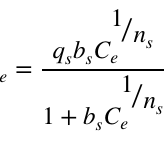
Table 3 Thermodynamics parameters for adsorption of Cr(VI)